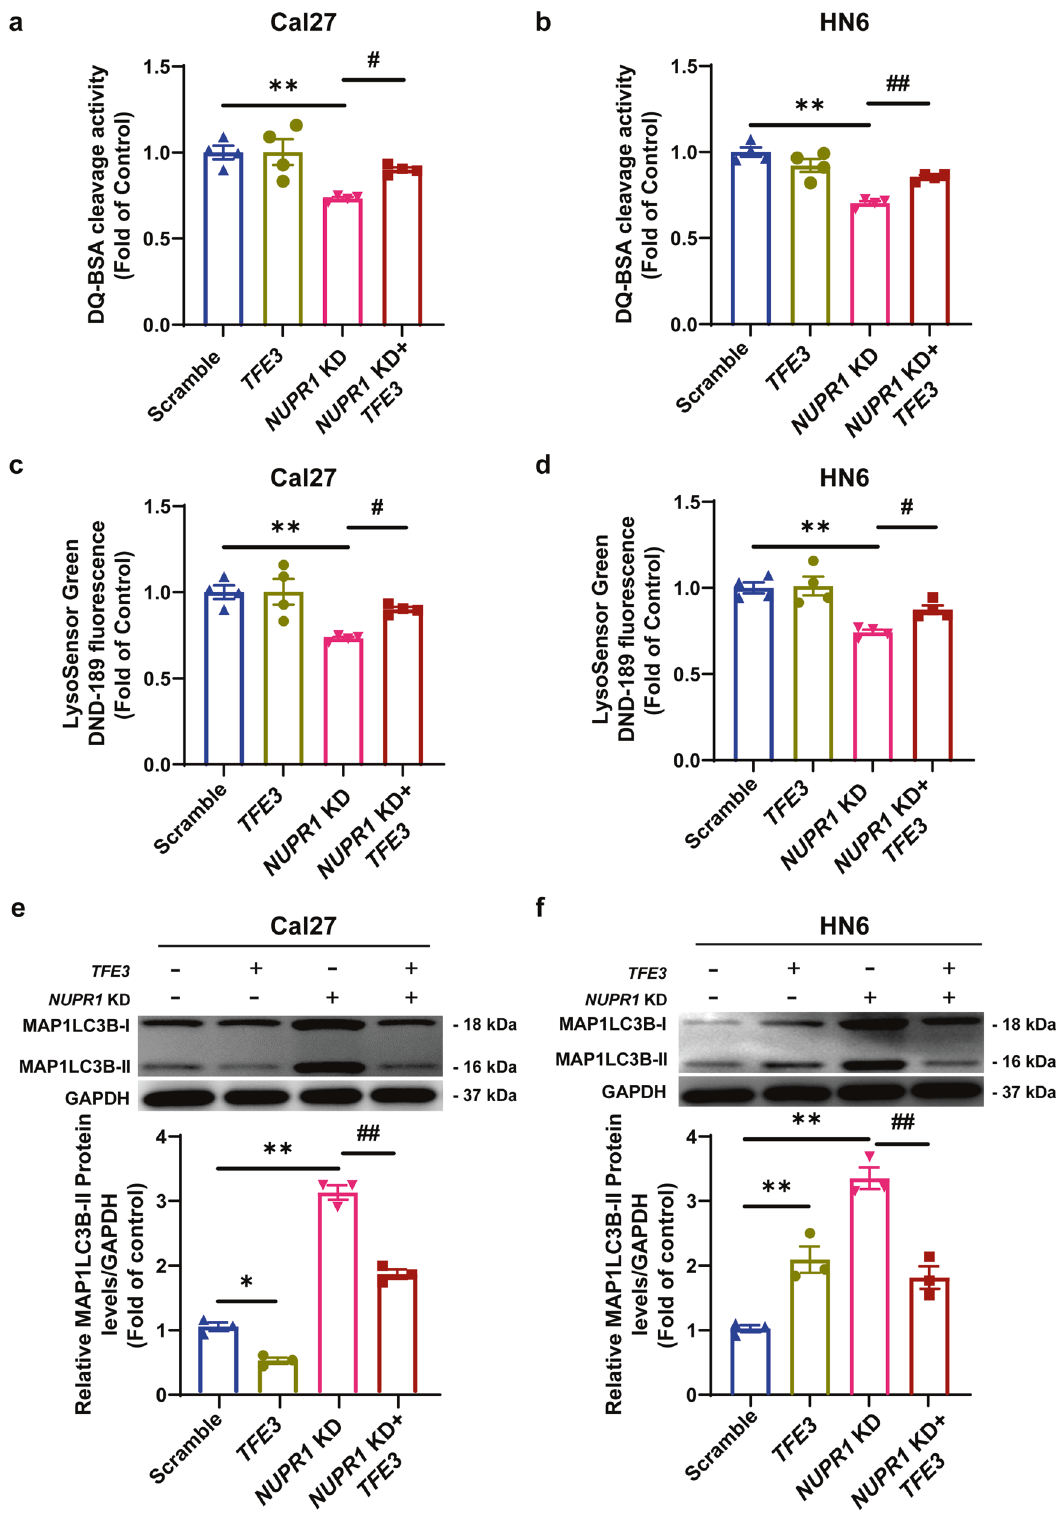
Fig. 4 TFE3 overexpression rescued the NUPR1 KD-inhibited autophagic fl ux in OSCC cells. a , b DQ-BSA or c , d LysoSensor DND-189 fl uorescence intensity was detected in NUPR1 KD or scrambled Cal27 and HN6 cells transfected with TFE3 plasmid or a control plasmid for 24 h; n = 4. e , f Immunoblotting analysis of MAP1LC3B and SQSTM1 in NUPR1 KD or scrambled Cal27 and HN6 cells transfected with TFE3 plasmid or a control plasmid for 24 h; n = 3; * P < 0.05, ** P < 0.01 vs. the scrambled group. # P < 0.05, ## P < 0.01 vs. NUPR1 KD